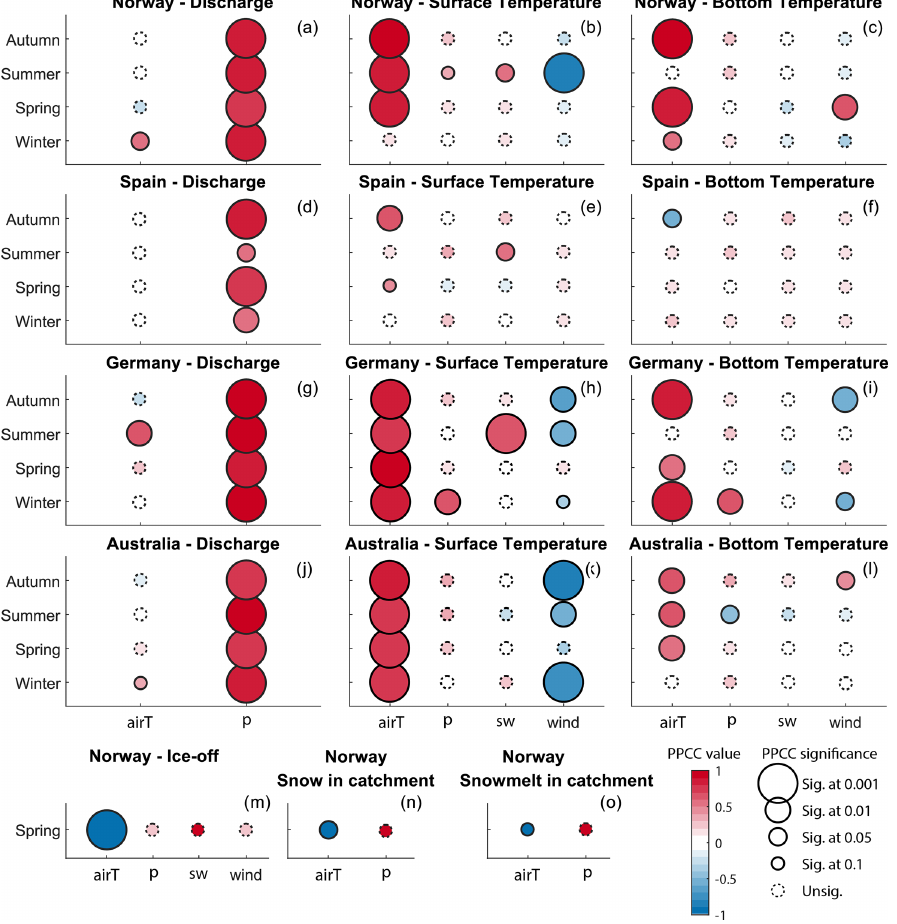
Figure 6. Pearson partial correlation coefficients (PPCCs) between Lake_PO seasonal means and seasonal means of selected input variables. Circle colour and size represent the PPCC value (from − 1 to 1) and significance, respectively. The meteorological variable abbreviations, airT, P , wind, cc, hum and sw, stand for surface air temperature, precipitation, wind speed, cloud cover, relative humidity (or dewpoint temperature) and short-wave radiation, respectively. Only significance levels at 0.1 or below were considered in the